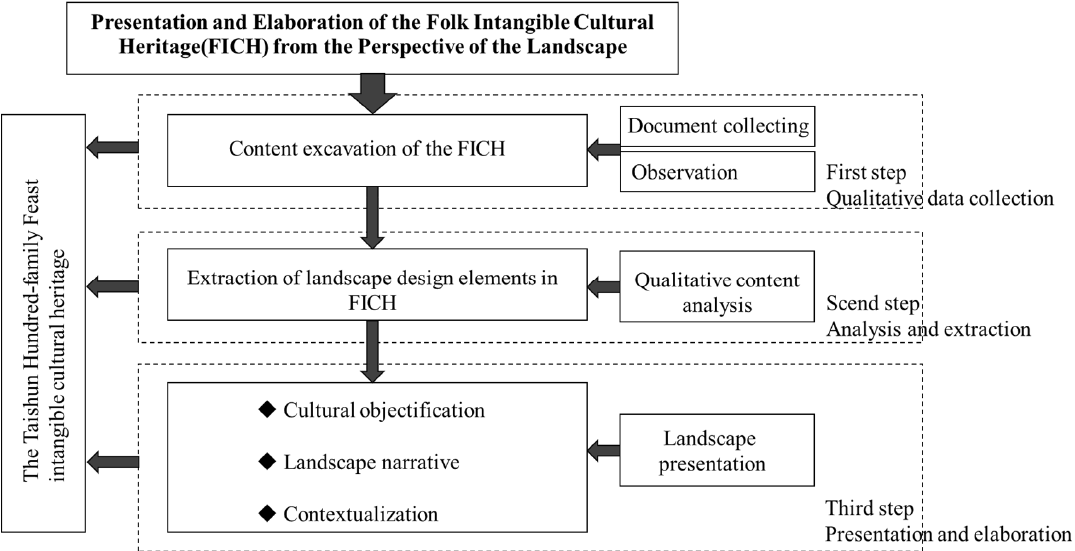
Figure 2. The research process of presentation and elaboration of the folk intangible cultural heritage from the perspective of the landscape. from the perspective of the